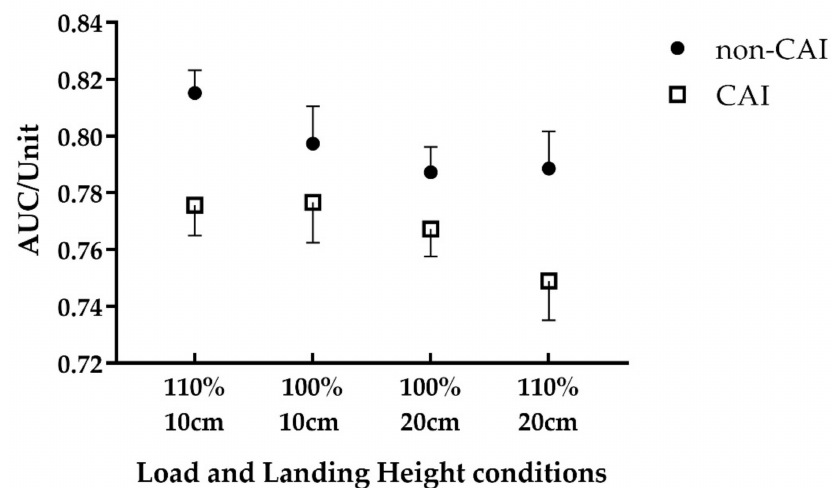
Figure 4. Differences in ankle inversion discrimination tested during landing heights and loads between individuals with and without CAI. A total of 100% indicated original body weight and 110% indicated 10% extra body weight; 10 cm and 20 cm represented landing heights. Compared to non-CAI, CAI showed significantly worse ankle inversion proprioceptive performance during landing (F = 6.120, p = 0.018), and the AUC score decreased by increased landing height for all participants (F = 7.216, p =